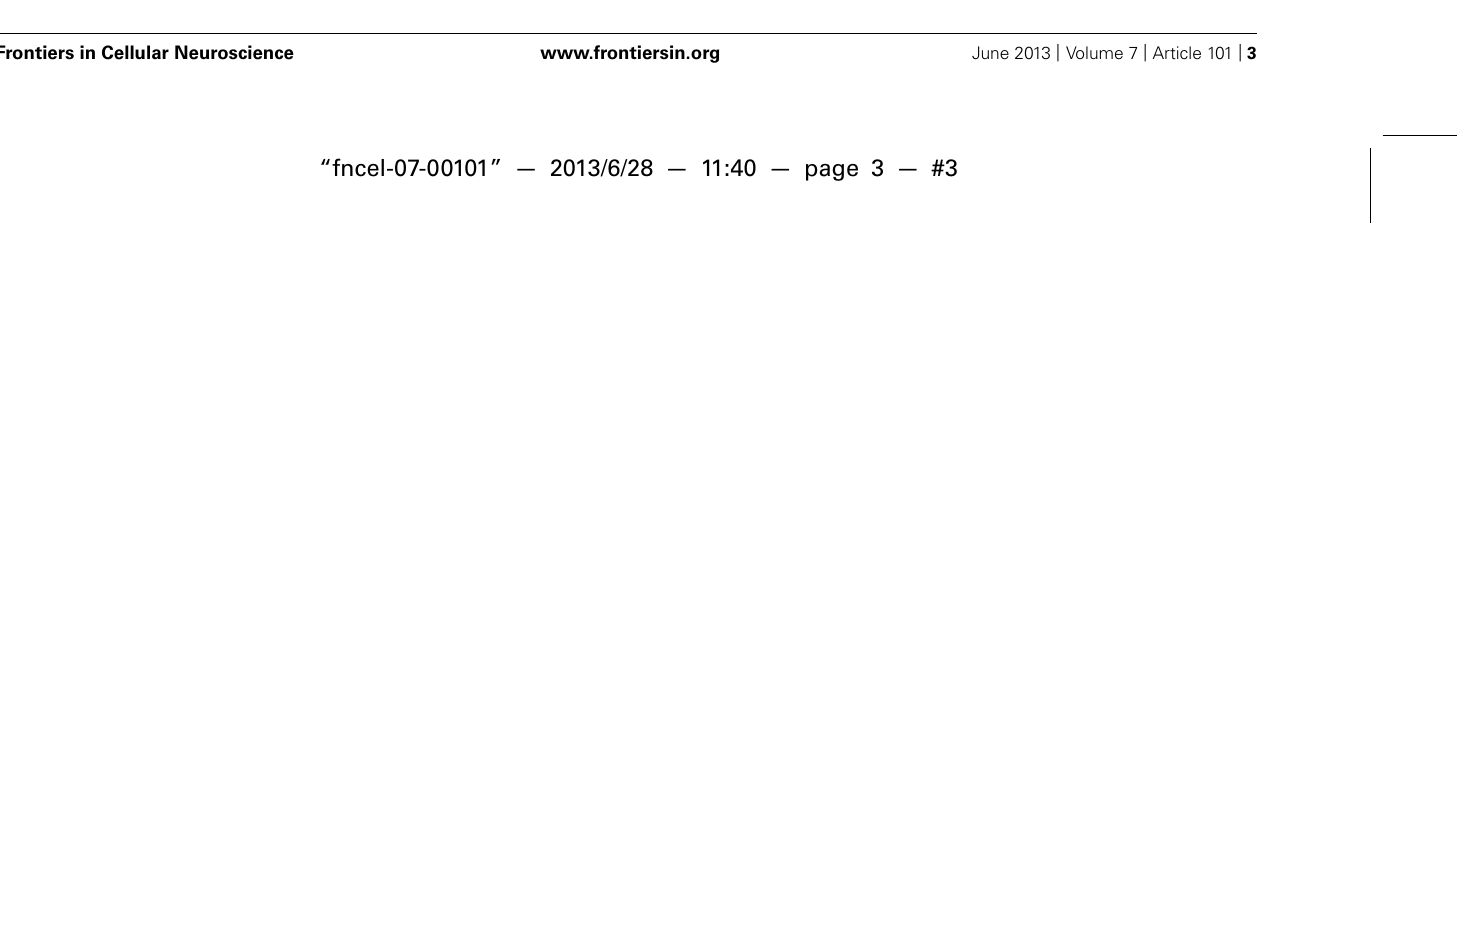
SV, synaptic vesicle. (C) Western blots comparing proteins in the synaptosome surface membrane and SV fractions.The same protein load was added to each lane. Purity of the SV fraction is indicated by the enrichment of SV2 andVAMP. However, many proteins generally associated with one or other compartment were present in both, including Rab3a, STG1, synapsin, STX1, and SNAP25. CaV2.2 serves as a surface membrane marker. See Figure 1 for the fraction